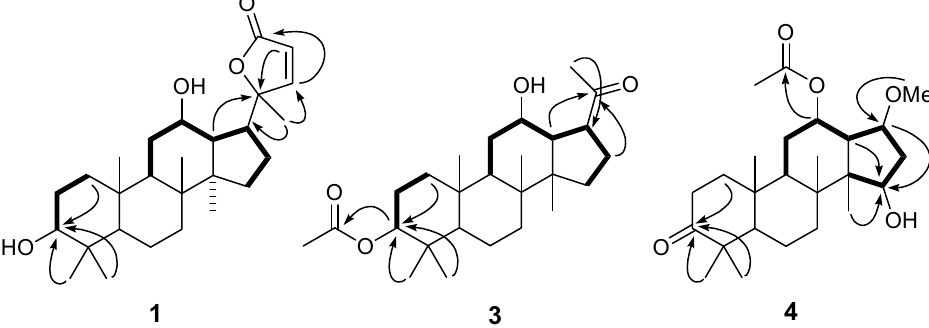
Figure 2. Key HMBC ( ) and 1 H- 1 H COSY ( ) correlations of compounds 1 , 3 and 4